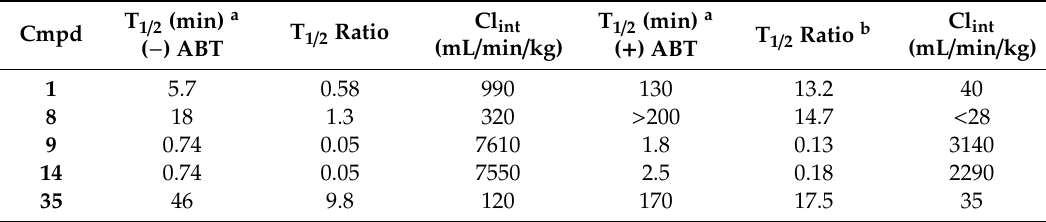
Table 4. Pharmacokinetic profile of 1 and 8 with and without pre-administration of ABT. Cmpd